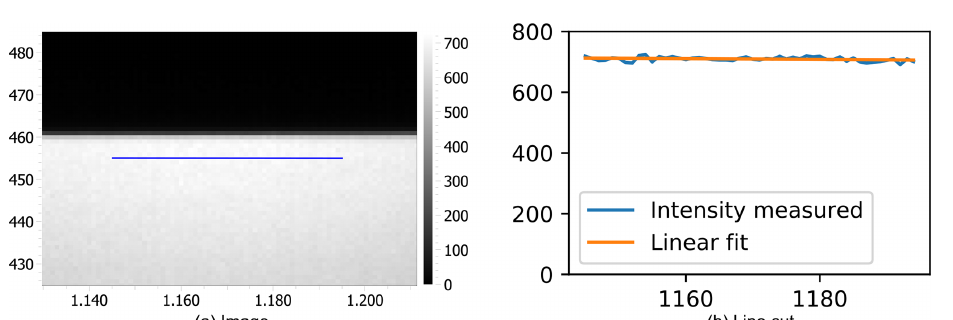
Figure 7. (a) Image of the pick-off mirror in the position of the device input, taken by image sensor without cover glass. (b) Intensity along the horizontal line depicted in (a)